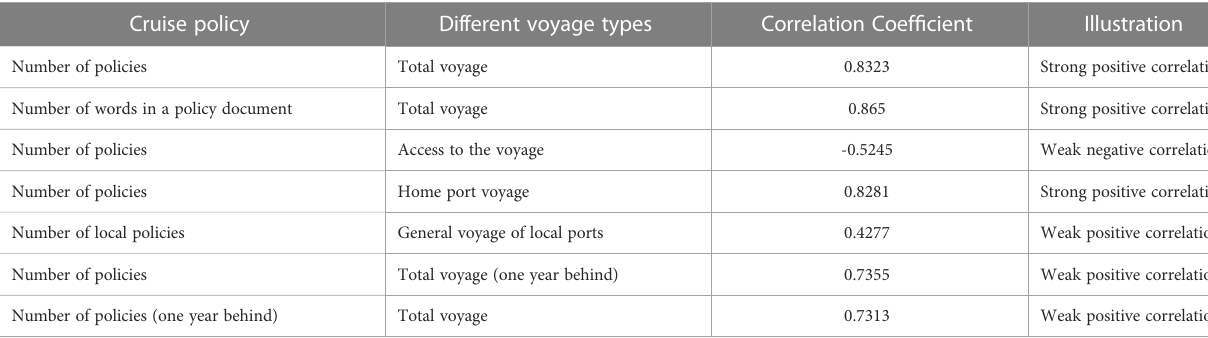
TABLE 2 The correlation between the number of cruise policies and voyages between 2007 and 2019. Cruise policy Different voyage types